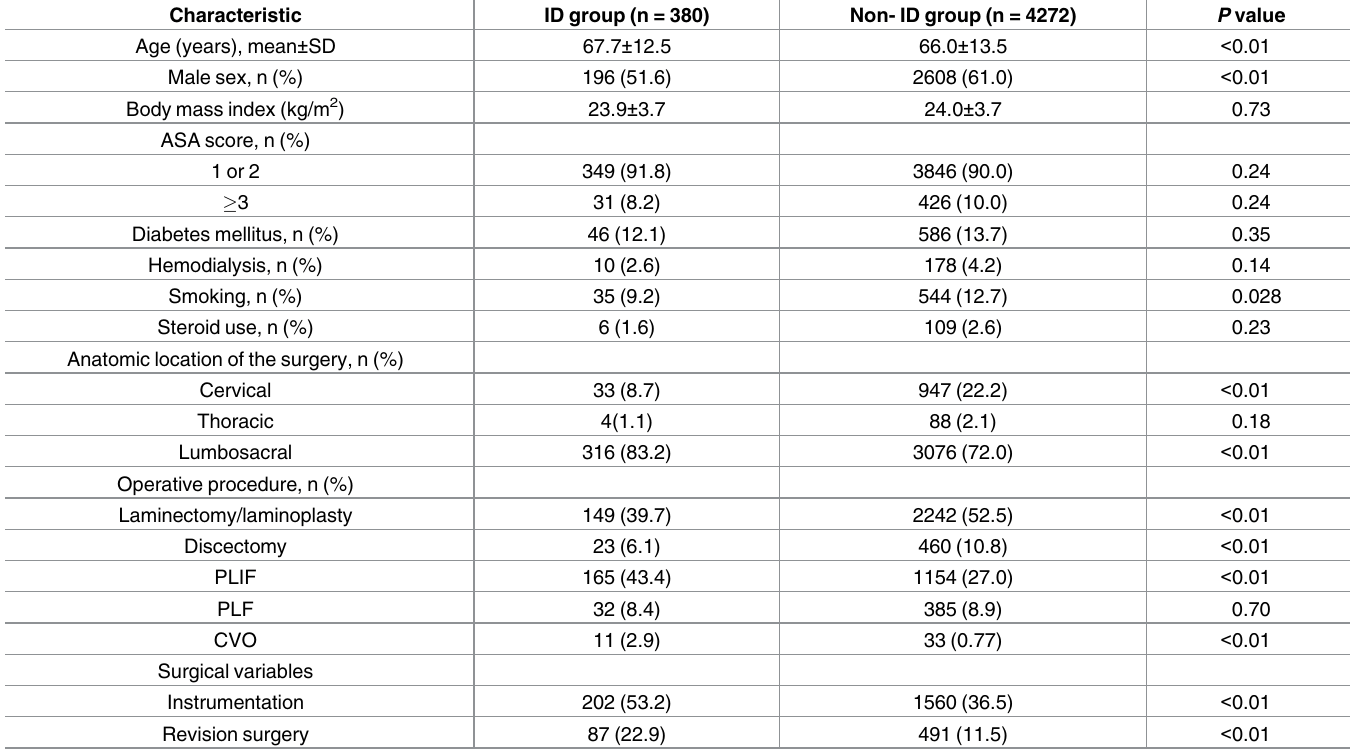
Table 1. Demographic characteristics of the ID group and Non-ID